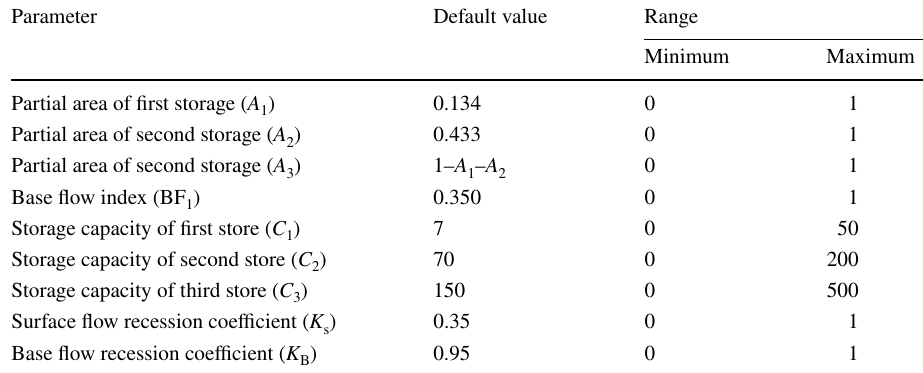
Table 3 Range and default values of parameters in AWBM